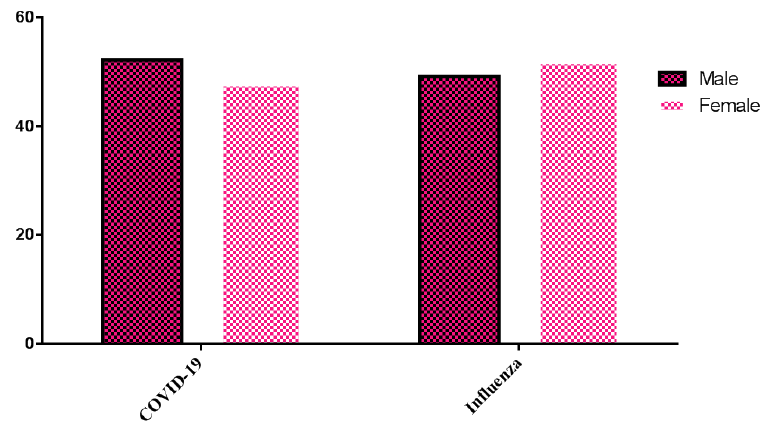
Figure 2. The Incidence of Influenza and COVID-19 in Males and Females During 2019-2021. Note. COVID-19: Coronavirus disease 2019.